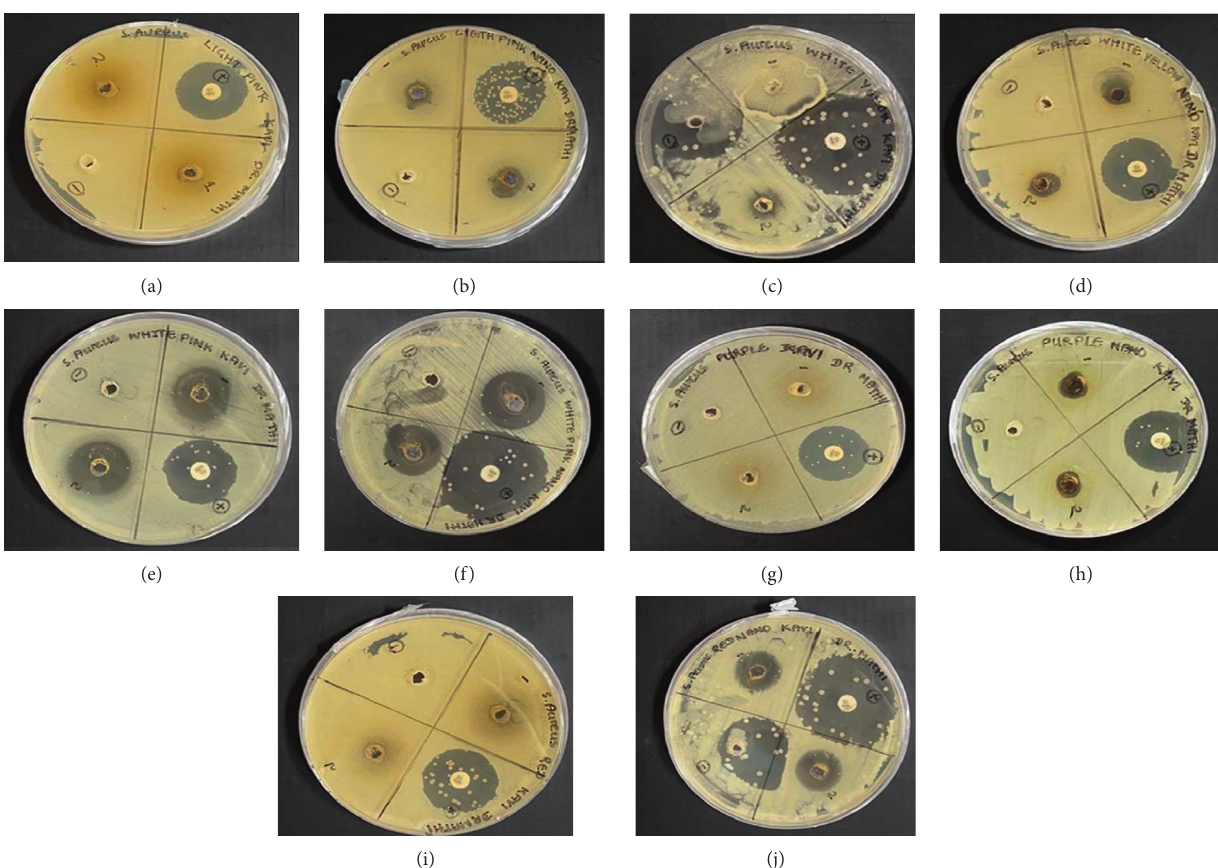
Figure 23: Antimicrobial activity of synthesized AgNPs and their respective flower extracts against Staphylococcus aureus . (a) Light pink flower extract. (b) Light pink AgNPs. (c) White yellow flower extract. (d) White yellow AgNPs. (e) White pink flower extract. (f) White pink AgNPs. (g) Purple flower extract. (h) Purple AgNPs. (i) Red flower extract. (j) Red AgNPs.